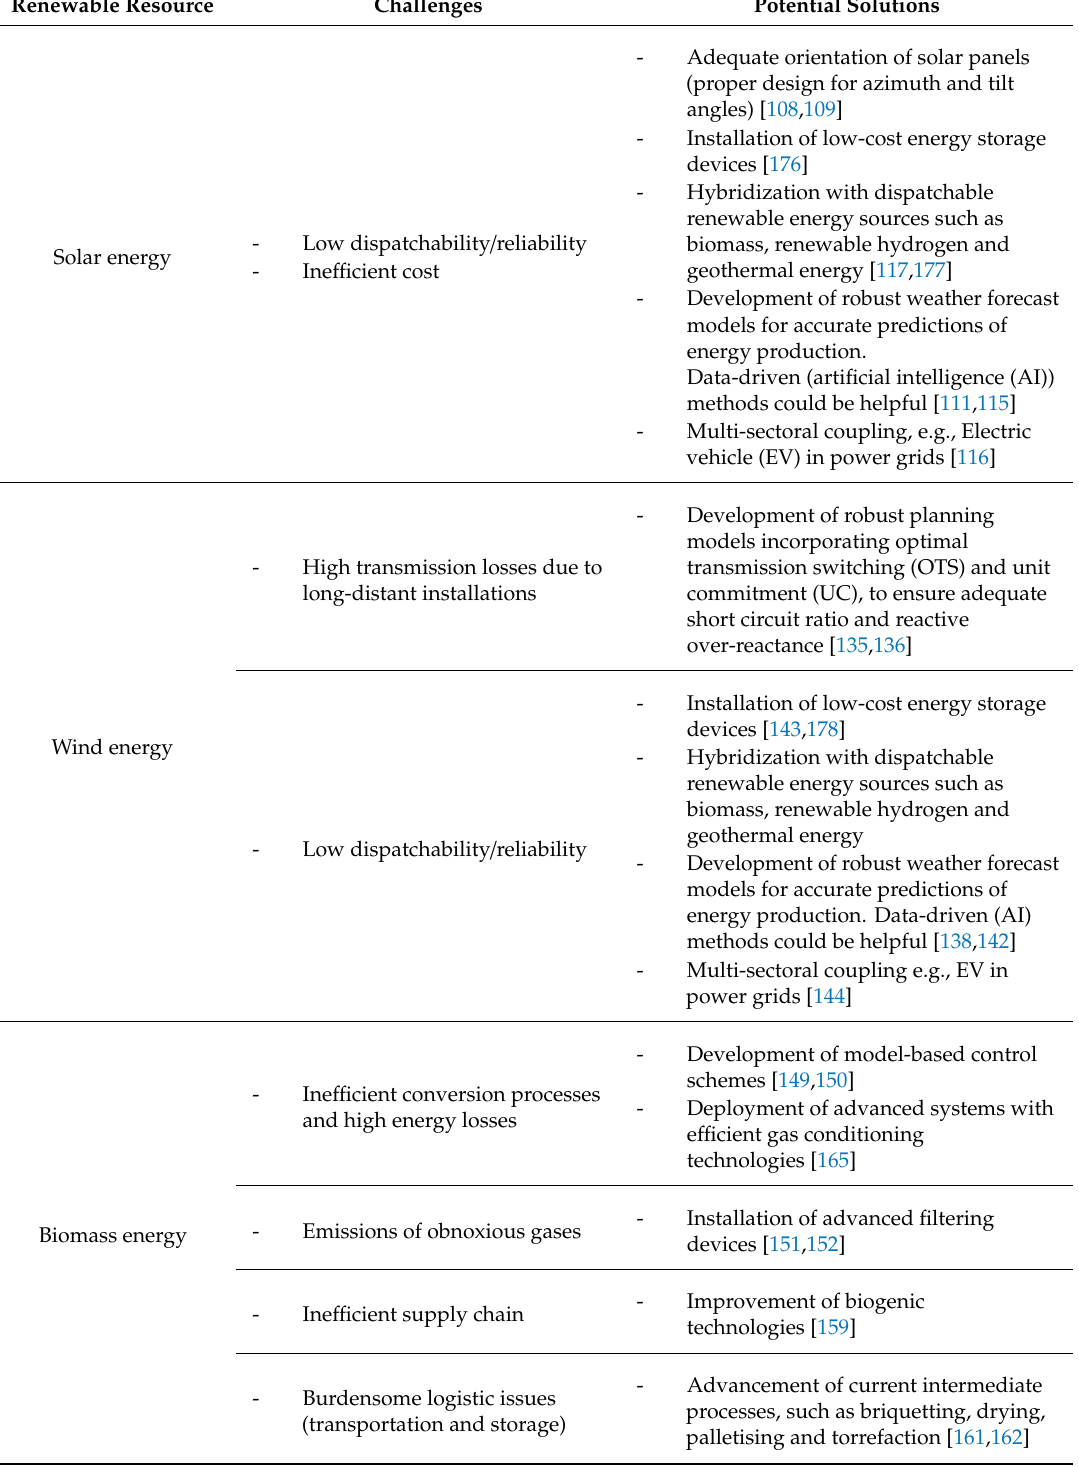
Table 2. Common challenges of grid-integrated renewable energy sources at power generation phase. Renewable